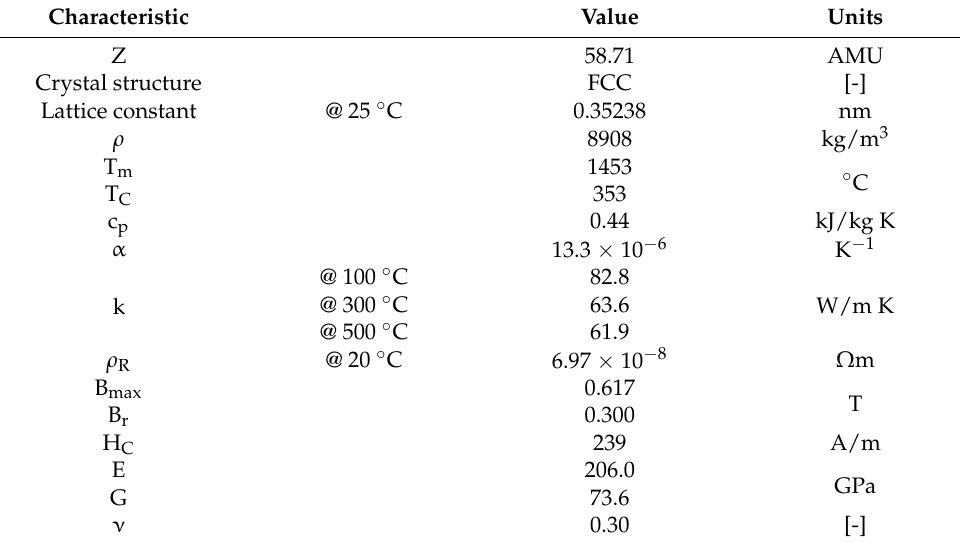
Table 1. Some physical properties of nickel (adapted from [7]).